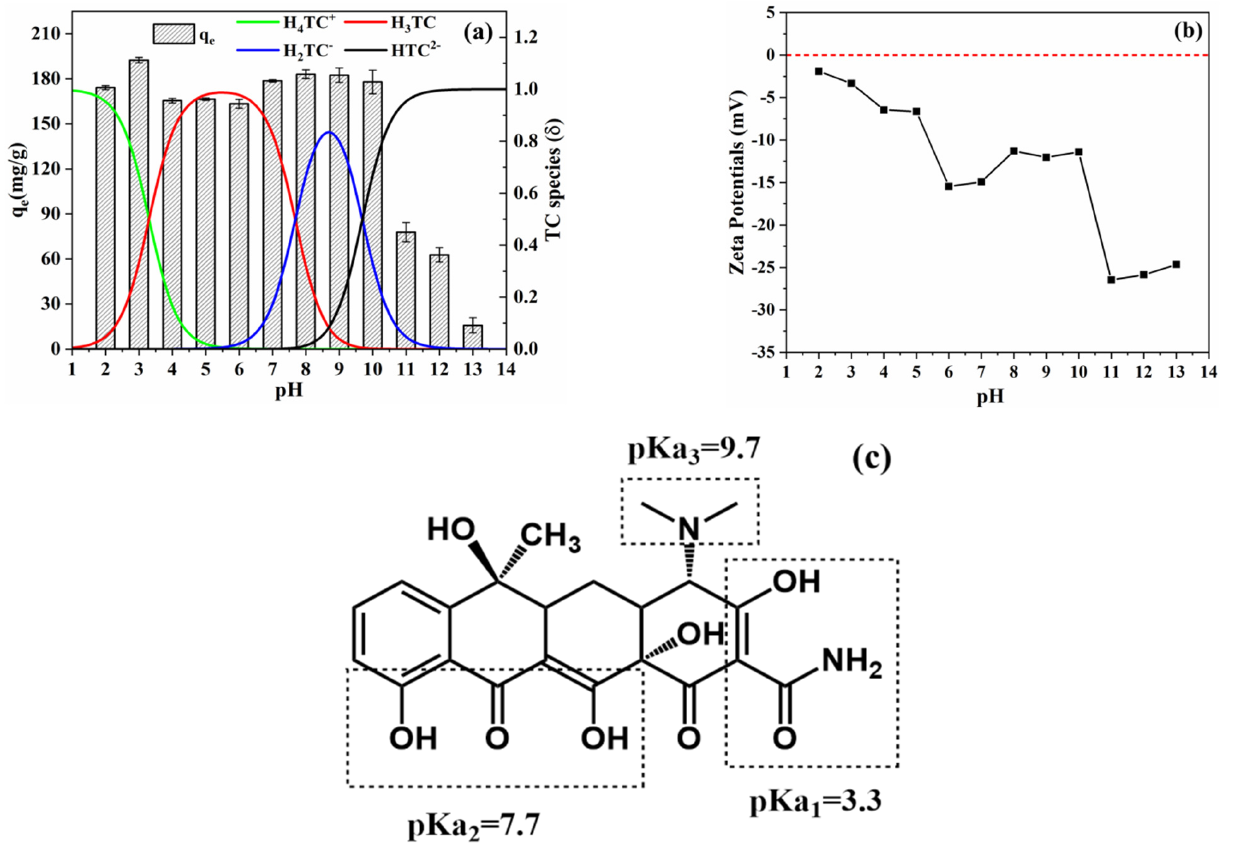
Figure 8. ( a ) The pH effect on TC adsorption, ( b ) zeta potential of P-POPs-3 and ( c ) the molecule structure and ionization constants of TC.